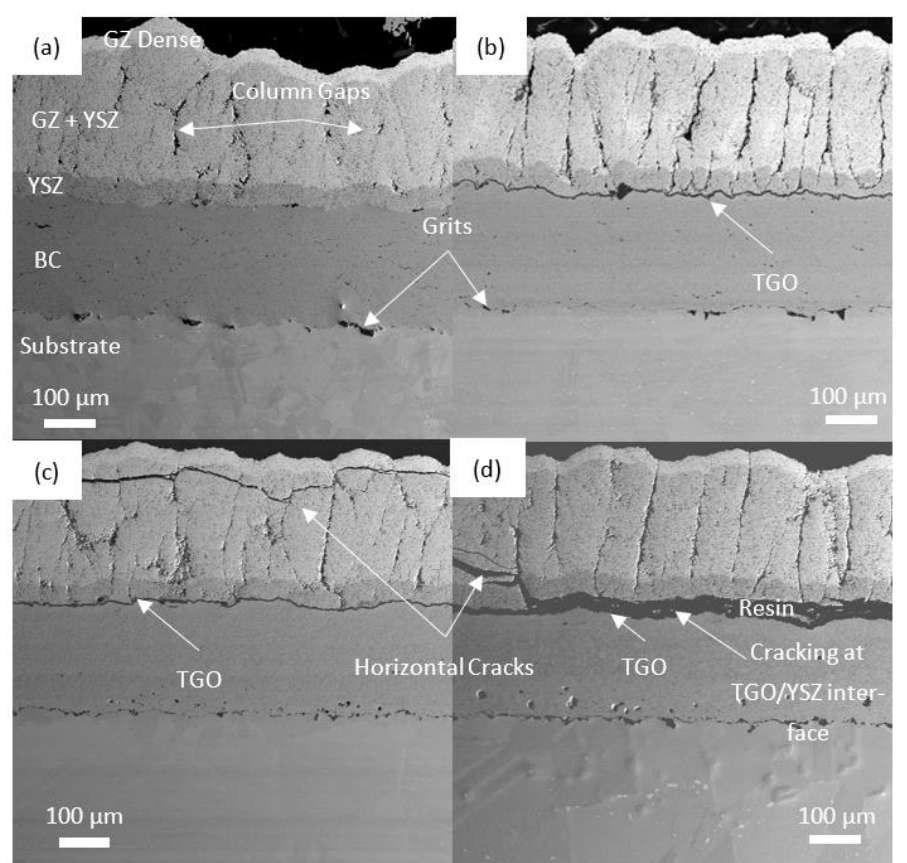
Figure 5. BSE of the composite layered TBC ( a ) as sprayed, ( b – d ) 1, 10, 100 h, respectively. For comparison, Figure 6a–d shows the thickness of single layer YSZ is 256.1 ± 21.5 µ m with a bond coat of 171.6 ± 8.8 µ m, with a TGO thickness of 3 ± 0.5 µ m, 3.4 ± 0.5 µ m, and 11.4 ± 1.4 µ m, respectively. After 10 h, a horizontal crack is observed in YSZ which is 60 µ m from TGO (Figure 6c). Also, vertical cracks formed at the YSZ columnar interfaces can be observed, which can influence the thermal barrier efficiency. After 100 h, cracks are observed at the TGO/YSZ interface which leads to final delamination of the coatings (Figure 6d) with a TGO thickness above critical value.